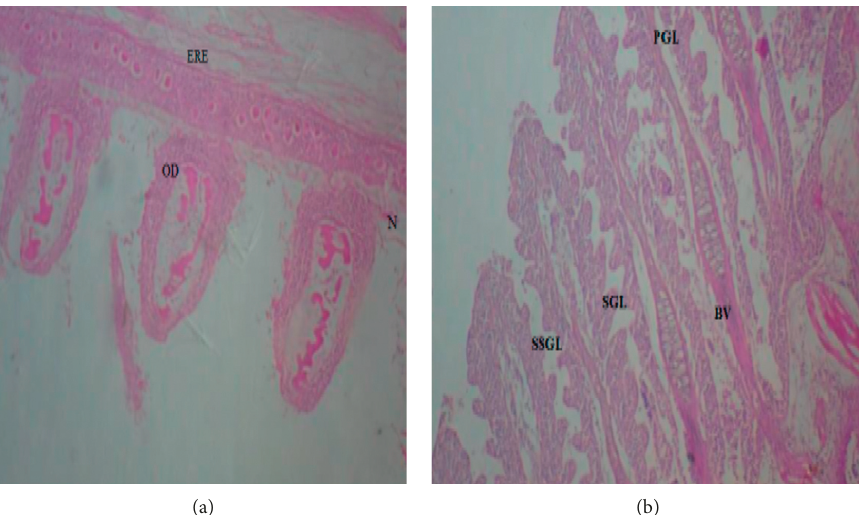
Figure 1: (a) Histological section of gill of fish for control experiment showing primary gill lamella (PGL), blunt secondary gill lamella (SSGL), and blood vessel (BV) (H&E stains, × 400). (b) Histological section of gill of fish exposed to nanosize SiO showing total destruction of primary gill lamella (PGL) and secondary gill lamellae (SGL), eroded epithelium (ERE), and area of severe necrosis (N) and oedema (OD) (H&E stains, ×